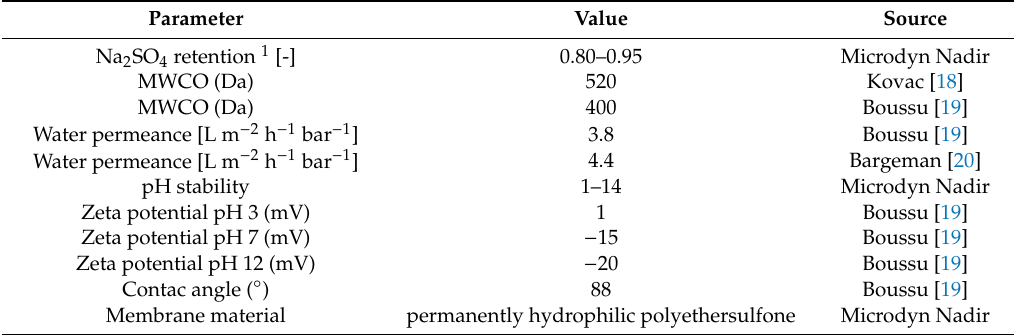
Table 1. Overview of the membrane specifications found in the literature and on the material data sheet provided from the